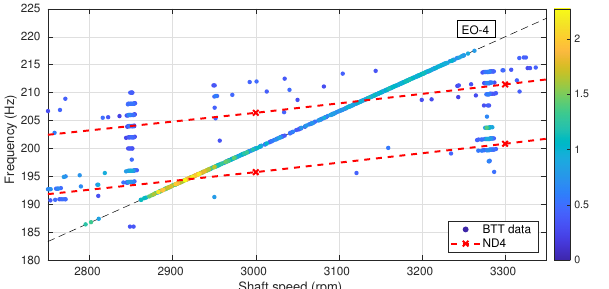
Figure 5. Blade displacement from BTT for the alternate mistuning configuration [01] with an EO4